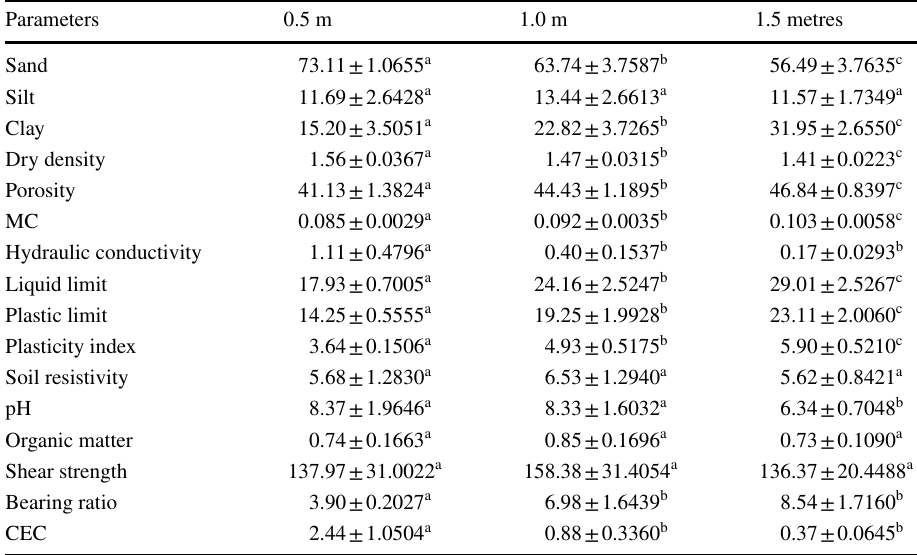
*Values show mean ± standard deviation. Values along the same row with the same superscript are not sig- nificantly different at 5% ( p >